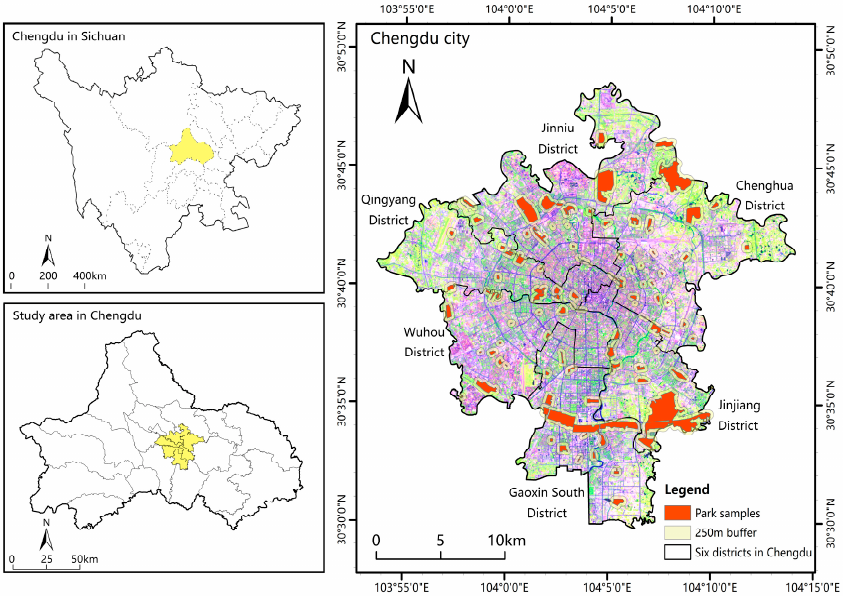
Figure 1. Location of Chengdu in Sichuan Province and the 117 park samples in the study area.